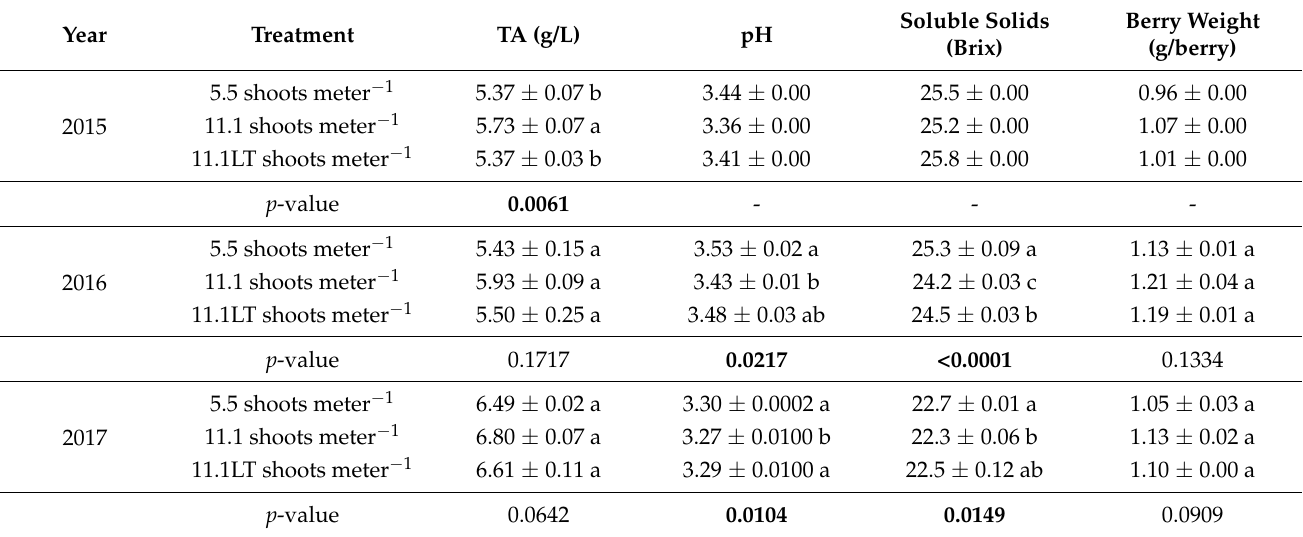
Table 10. One-way analysis of variance (ANOVA) showing average TA (g/L), pH, brix, and berry weight (g/berry) by year and treatment at harvest during the 2015, 2016, and 2017 growing seasons ( n = 3). Table shows treatment means followed by the standard error of the mean. Different letters within a column indicate significant differences based on an Each pair, Student’s t -test. Significant p -values (<0.05) are displayed in